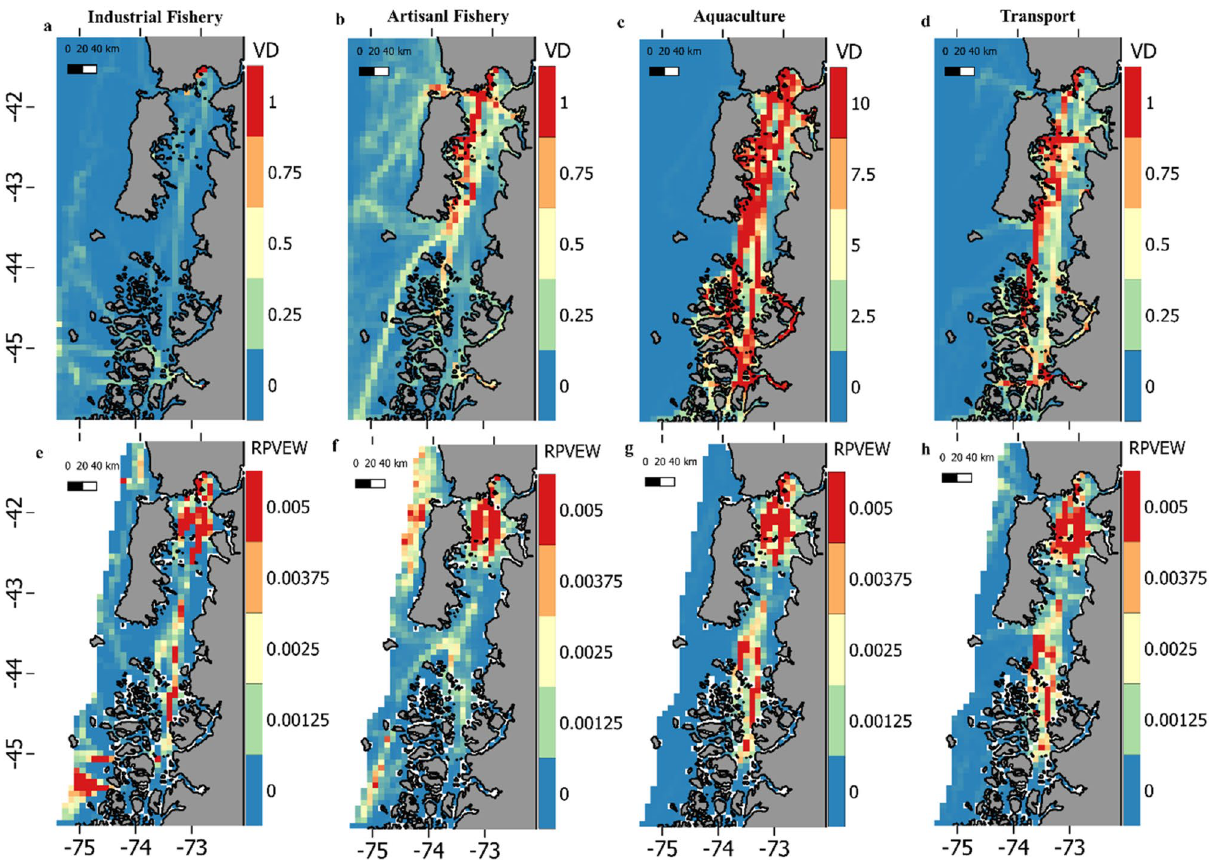
Figure 6. Top panels show vessel density (VD) as the mean number of vessels visiting each 8 × 8 km grid-cell per day, for the industrial fishery ( a ), artisanal fishery ( b ), aquaculture ( c ) and transport ( d ) fleets. Note the large difference in color bar increments for the aquaculture fleet. Bottom panels show the relative probability of vessel encountering whale (RPVEW) for the industrial fishery ( e ), artisanal fishery ( f ), aquaculture ( g ) and transport ( h ) fleets. The data of the different fleets are provided by the Chilean national services of fisheries and aquaculture, (SERNAPESCA) and are freely available at www.serna pesca .cl. Data layers (including maps) were created in R ver. 4.0.2 (www.r-proje ct.org) and ensembled in QGIS ver. 3.8.0 (www.qgis.org) for final rendering. Maps were created using data on bedrock topography from the National Centers for Environmental